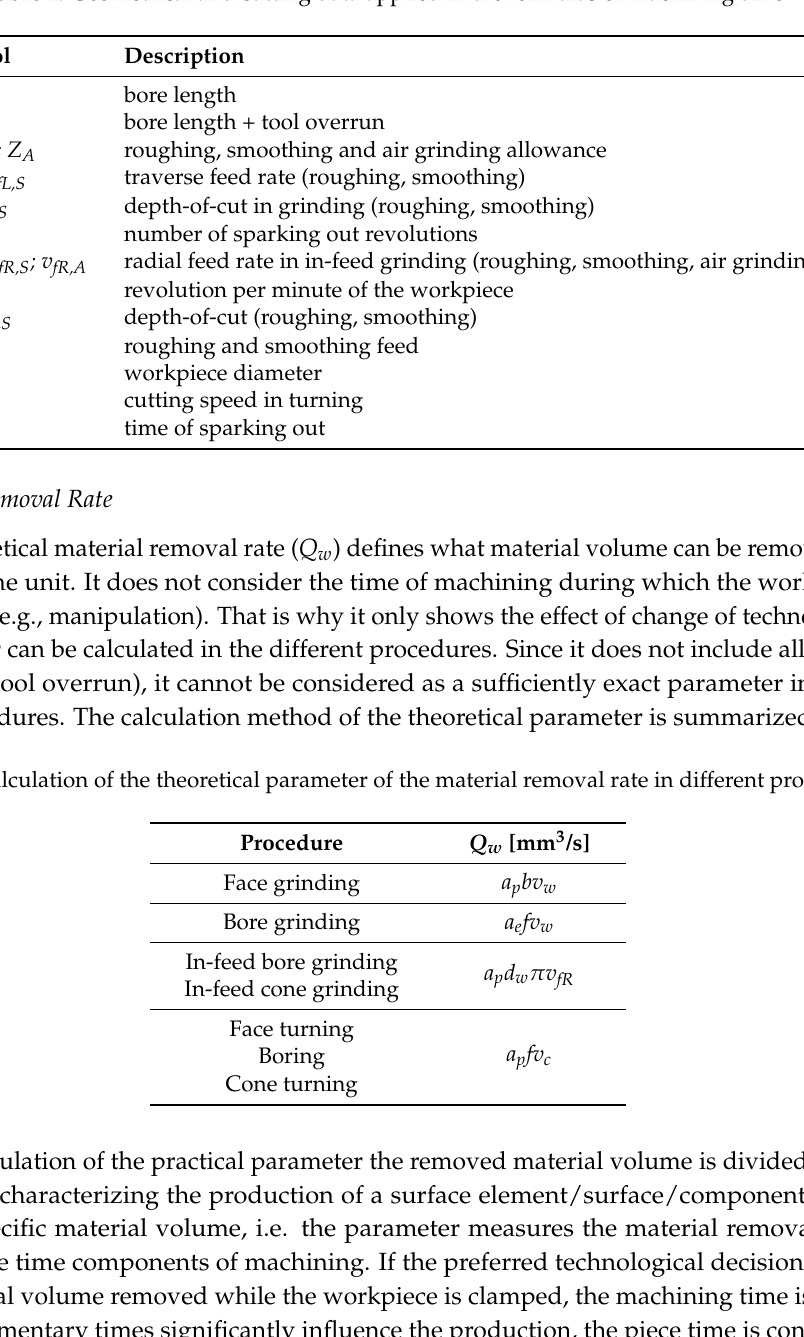
Table 1. Geometrical and cutting data applied in the formulas of machining time.